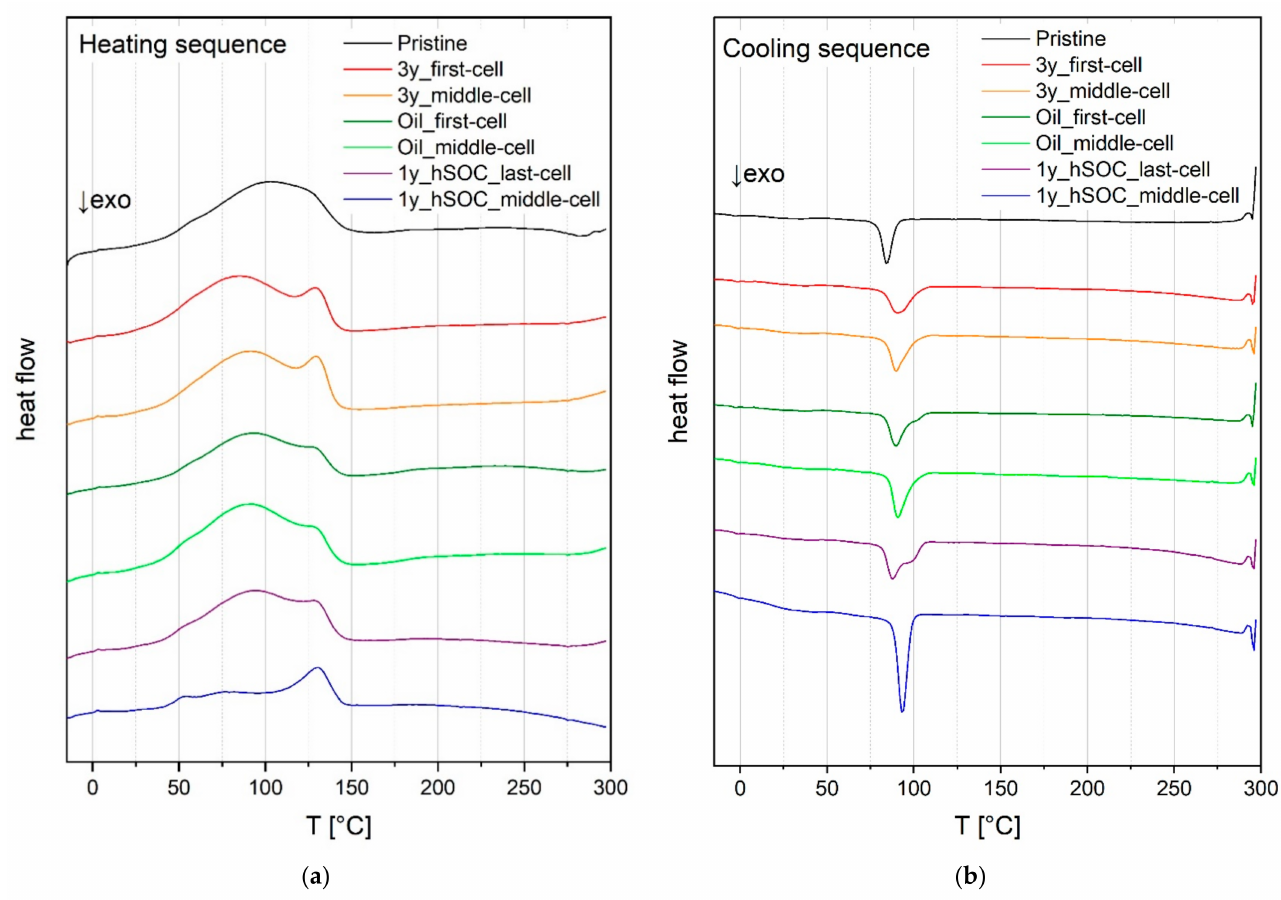
Figure 5. DSC of membranes retrieved from decommissioned stacks and pristine membrane; heating sequence ( a ) and cooling sequence ( b